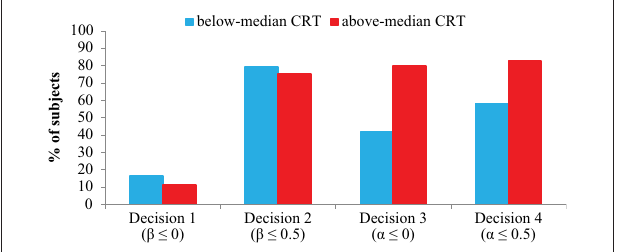
FIGURE 1 | Percentage of subjects choosing option B in each decision, by CRT groups (Study 1). The model parameters associated to option B are shown in